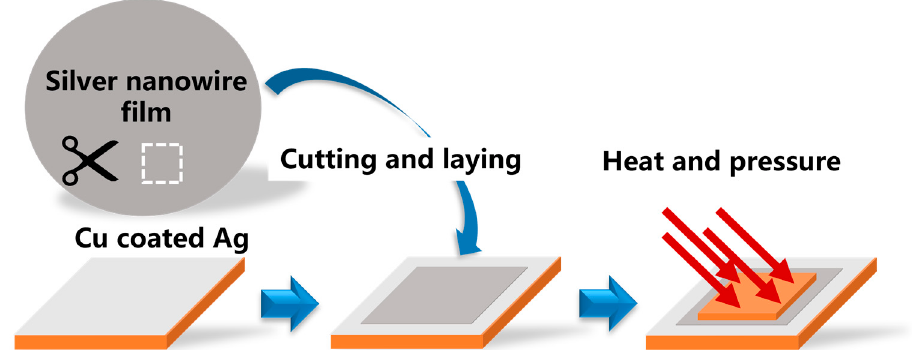
Figure 2. Diagram of hot-pressing of silver nanowire film.